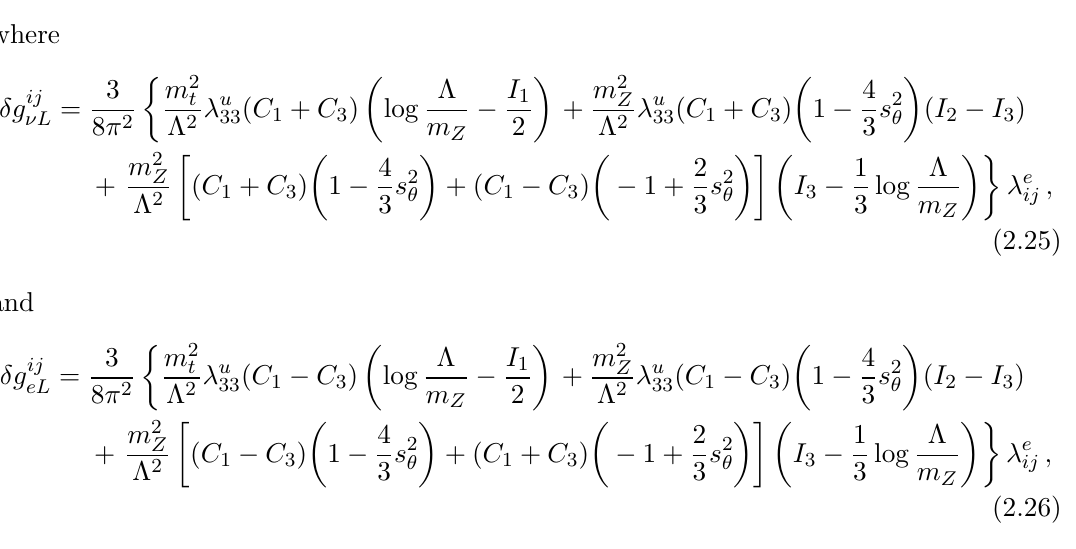
Figure 1 . Diagrams contributing to the decay of the Z into a lepton pair. On the left, the contribution from L W;Z , eq. (2.16). On the right the one-loop contribution originating from the four-fermion interactions contained in L 0 ((cid:3)), eq. (2.3), denoted by a square. The dependence on NP the renormalization scale (cid:22) cancels in the